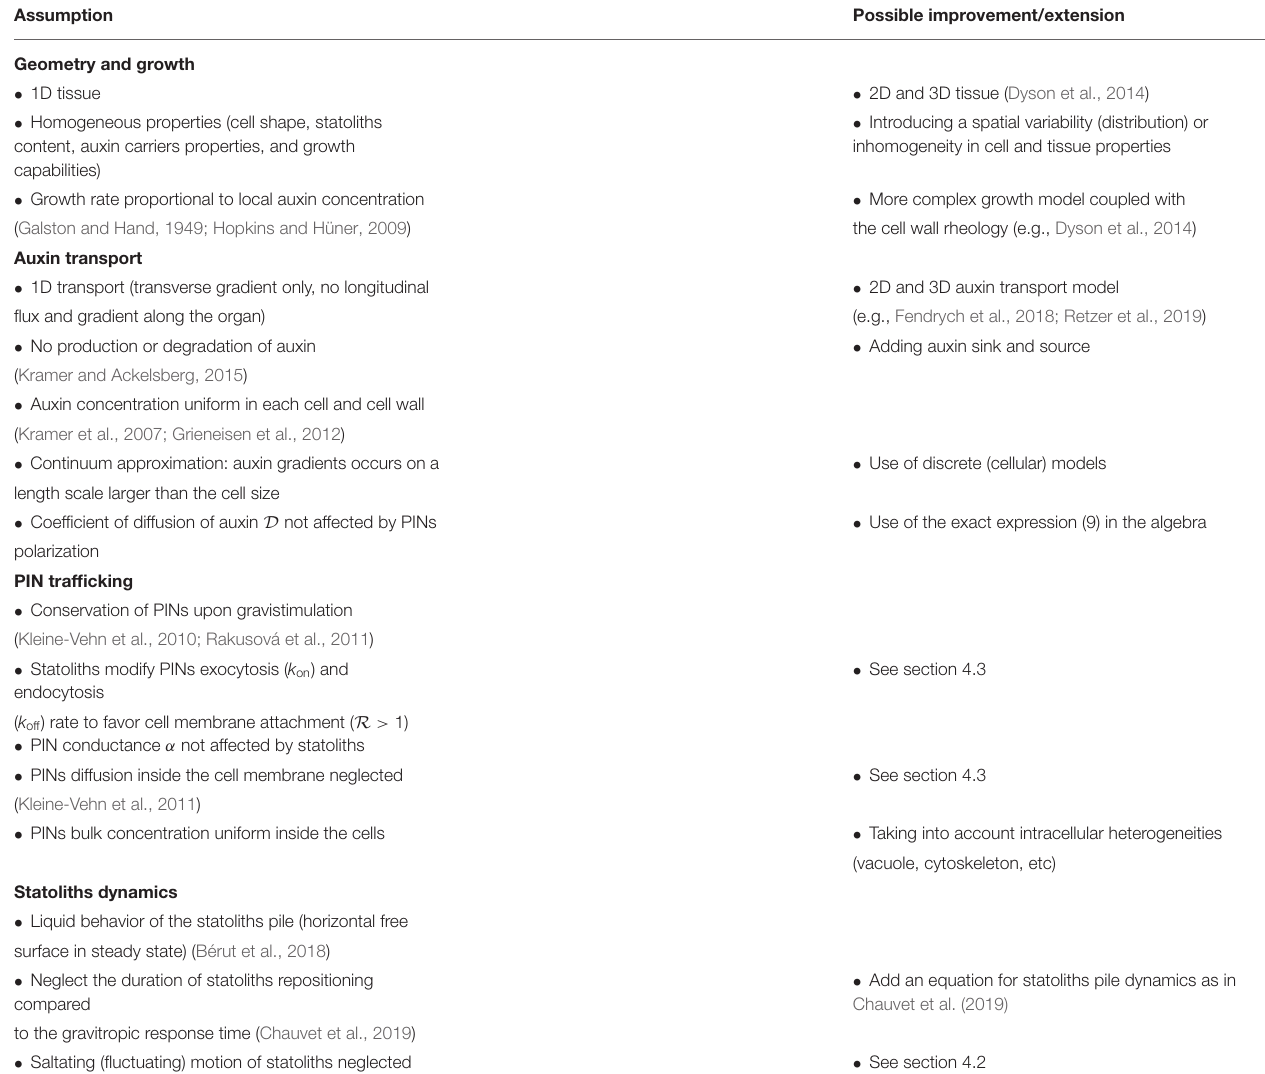
TABLE 3 | Assumptions used in the model and possible